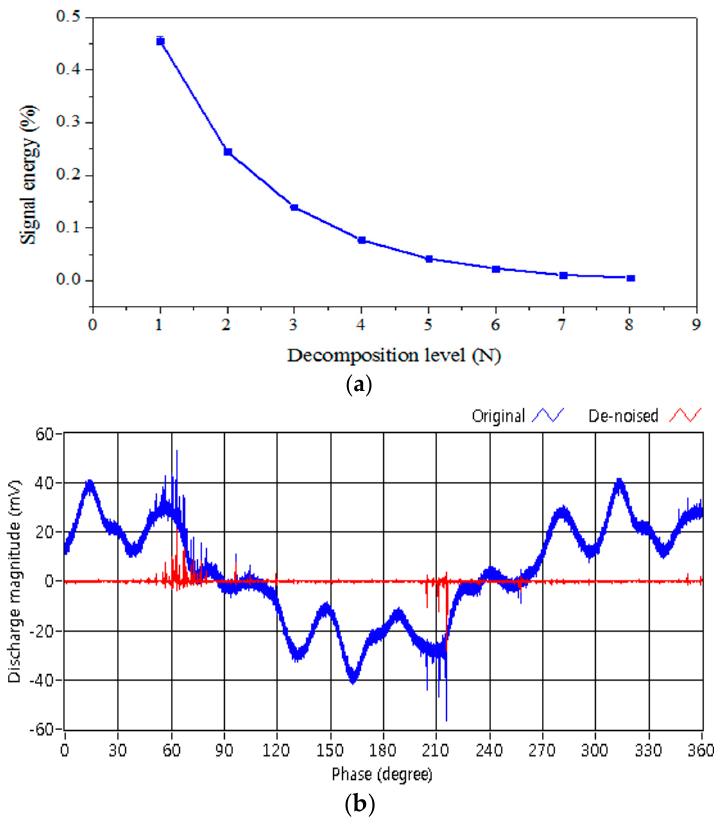
Figure 12. Disturbance elimination for PRPD in the crack. ( a ) Signal energy distribution; ( b ) extraction of PRPD.